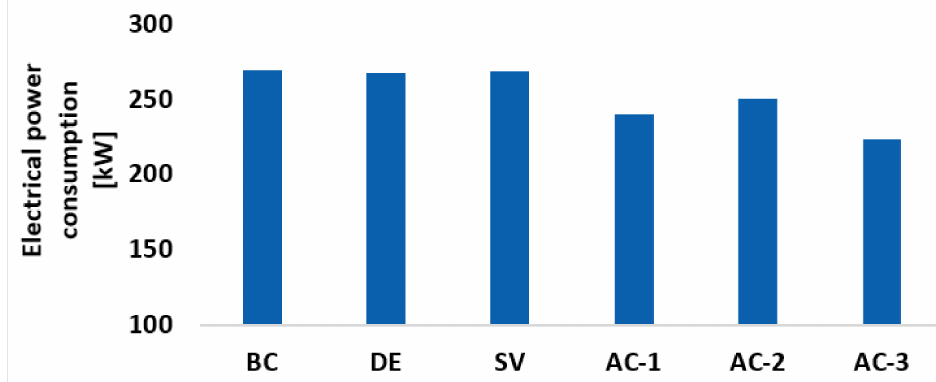
Figure 7. Electrical power consumption results for the several cases.